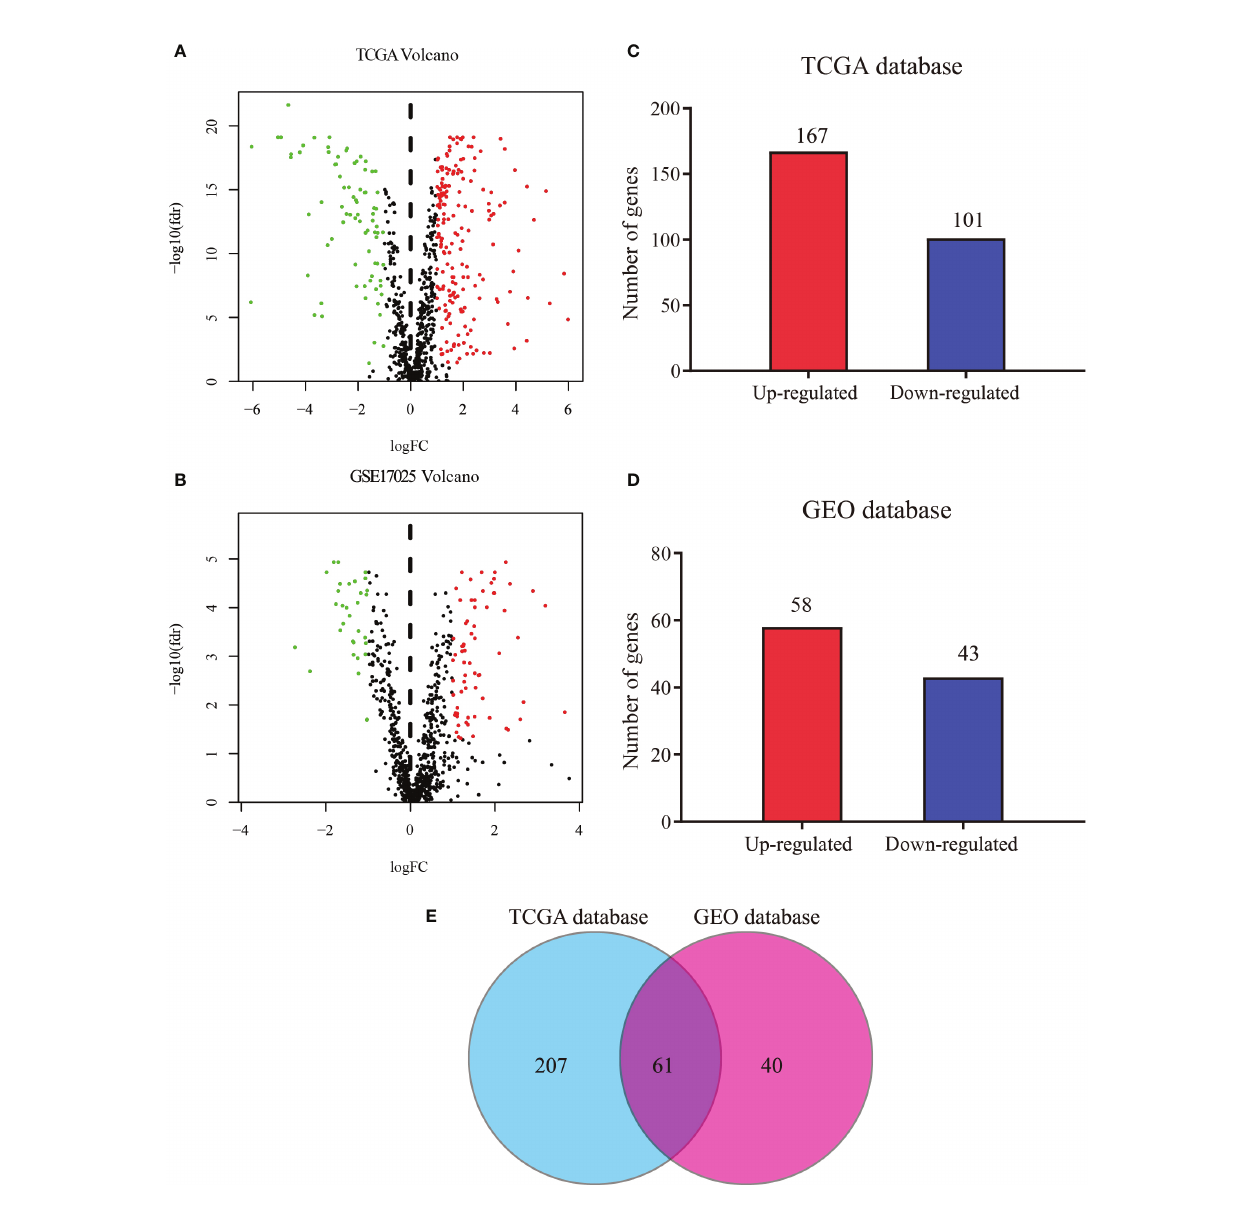
FIGURE 1 | Distribution of metabolism-related genes in TCGA and GEO databases. Volcano plot for DEGs in tumor and normal tissues in (A) TCGA database and (B) GEO database where red and green dots represent up- and down-regulated genes, respectively. Black dots represent genes with no signi fi cant change. Bar plot of up- and down-regulated genes in (C) TCGA database and (D) GEO database. (E) Venn diagram of DEGs in the two